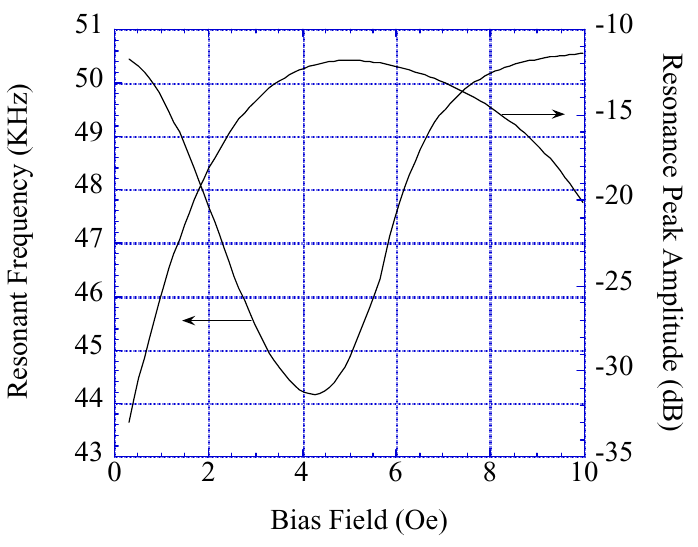
applied field amplitude H due to changing elasticity ( ∆ E effect).